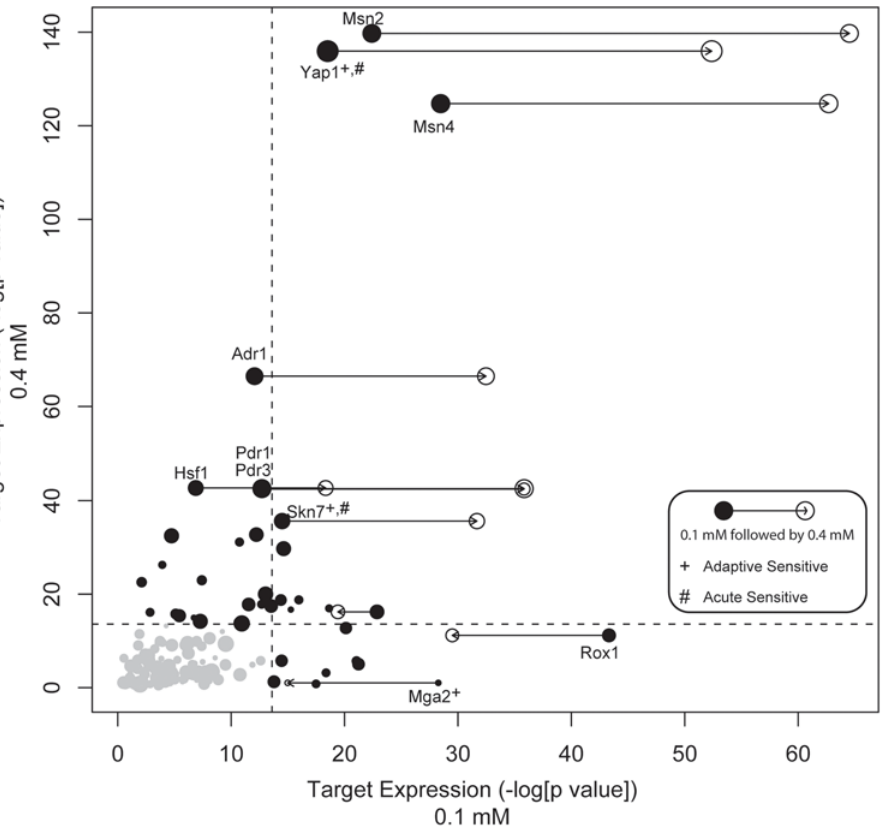
Figure 4. Dynamics of transcription factor target expression in mild and acute conditions. For each transcription factor, we compute a score based on a hypergeometric test representing the significance of increased expression (relative to untreated) of known targets (see Methods) following either pretreatment (0.1 mM H 2 O 2 , x-axis) or acute treatment (0.4 mM H 2 O 2 , y-axis). For those transcription factors with the most significant activity following pre- or acute treatment, the activity following adaptive treatment (0.1 mM followed by 0.4 mM H 2 O 2 ) is also displayed on the x-axis with an open circle. The size of each point corresponds to the number of known targets of that transcription factor. The dotted lines indicate a threshold for significance determined by a randomization procedure (see Methods). Although there is significant overlap in the set of expressed genes following mild and acute treatment, examination of specific transcription factors reveals those with unique behavior in each condition. Transcription factors identified in the deletion fitness analysis of the acute and adaptive treatments are indicated with ‘‘ # ’’ and ‘‘ + ’’ symbols, respectively.